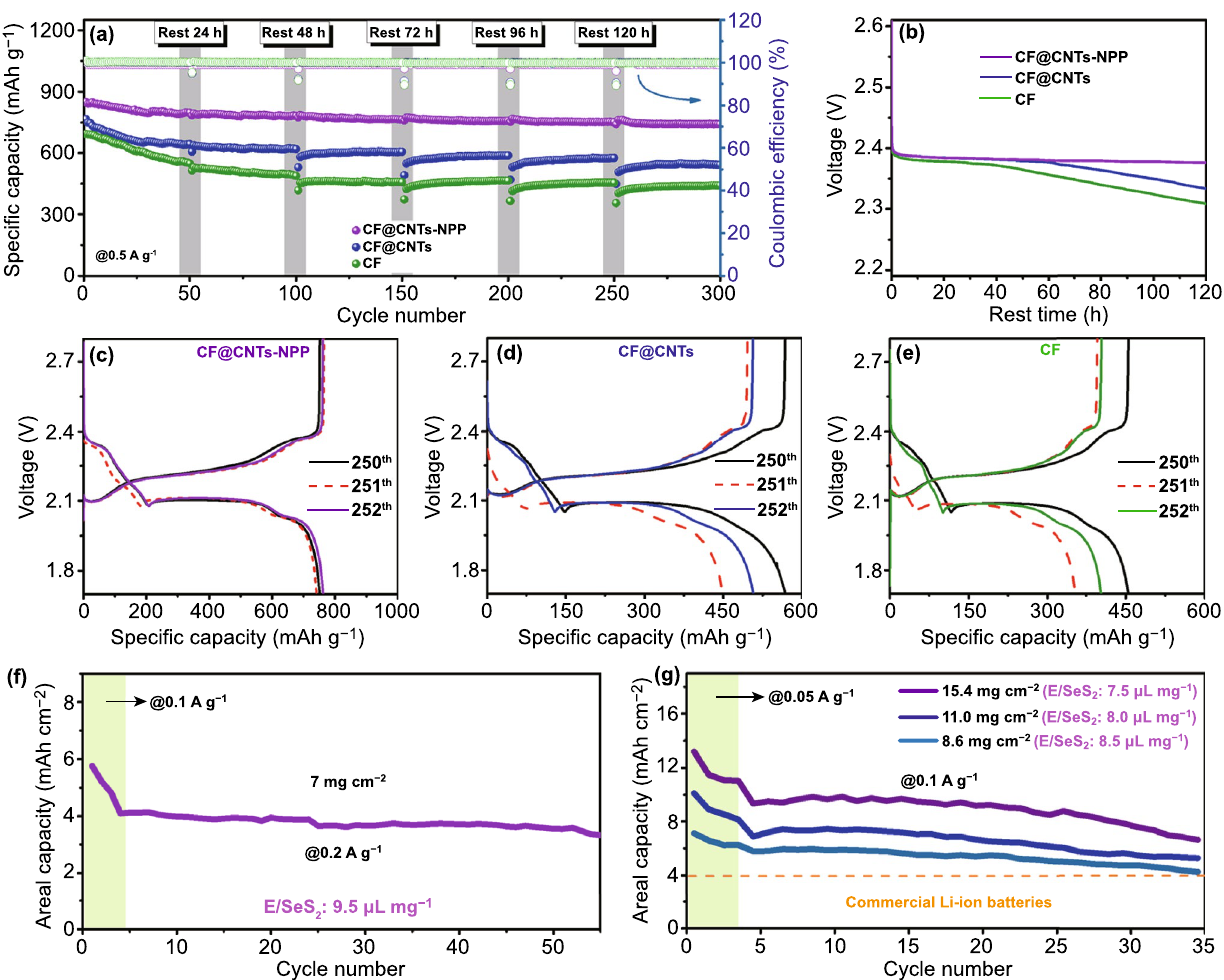
Fig. 5 a Cycling stability at 0.5 A g −1 after different rest periods of 24, 48, 72, 96, and 120 h. b Open-circuit voltage curves of the cells during the 120 h rest. c–e Discharge–charge curves before and after 120 h rest. Cycling performance of the high-SeS 2 -loading cathodes of f 7 mg cm −2 and g 8.6, 11, and 15.4 mg cm −2 of the Li–SeS 2 cells with the CF@CNTs-NPP